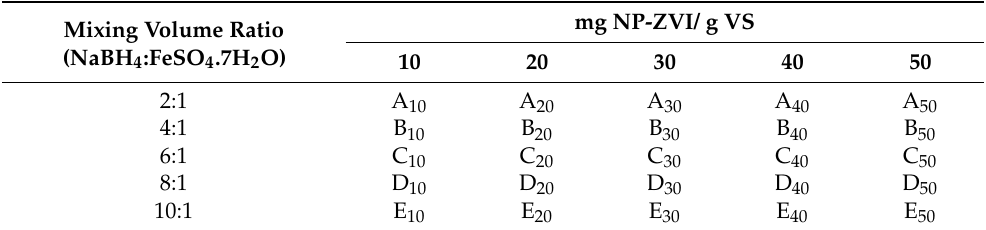
Table 1. Symbols of the BMP tests that were supplemented with various concentrations of NP-ZVI which were obtained at various